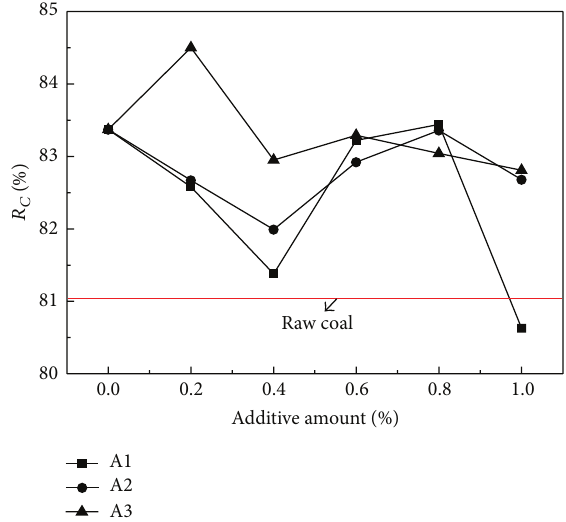
Figure 2: The effect of additive on 𝑅 𝐶 of C1.